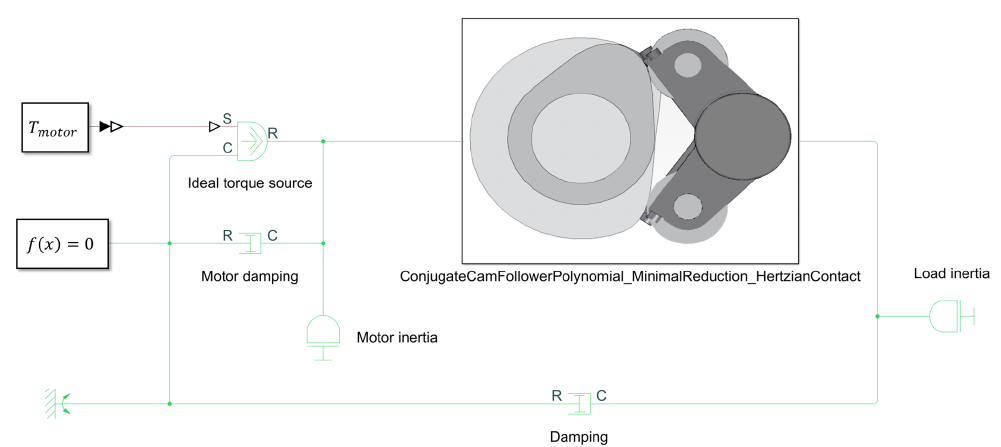
Figure 1. Simscape model implementing the conjugate cam-follower